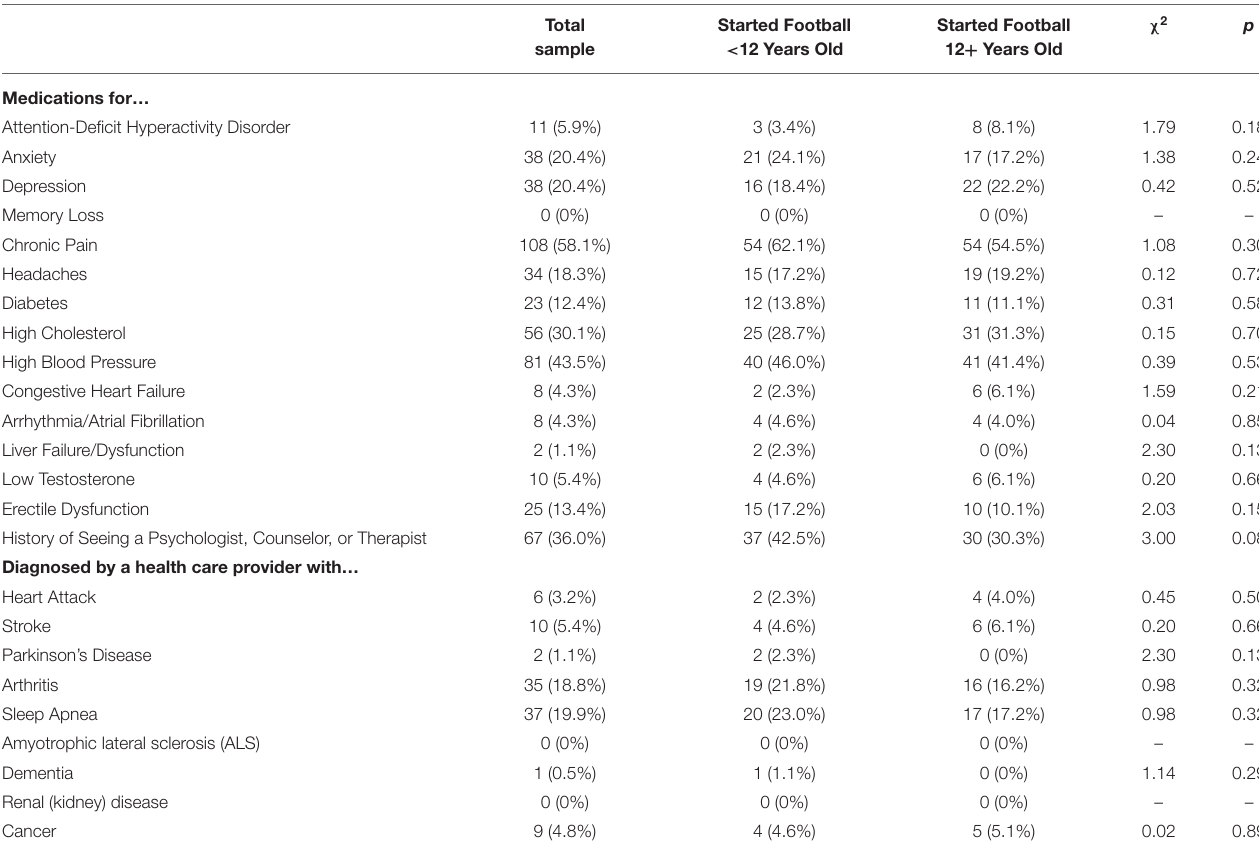
TABLE 2 | Frequencies of health conditions across football exposure